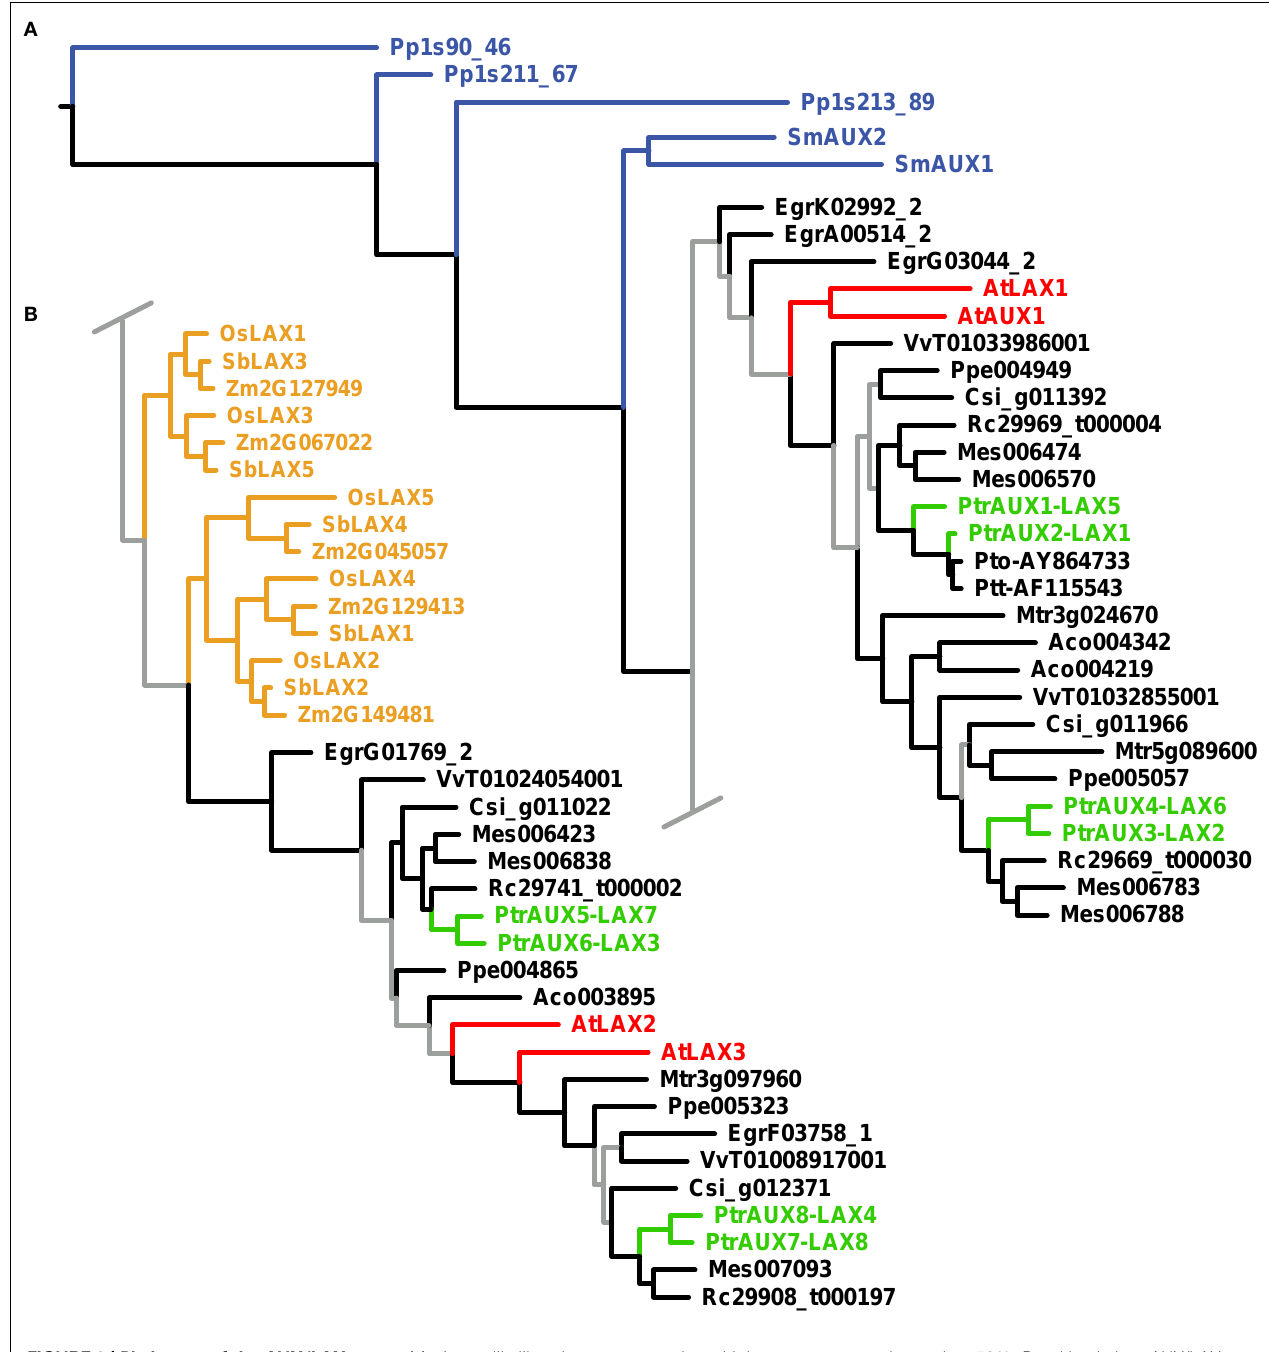
FIGURE 3 | Phylogeny of the AUX/LAX genes. Maximum likelihood phylogeny of AUX/LAX genes from land plants, based upon coding sequences from the loci listed in TableA4 in Appendix. Gray branches indicate